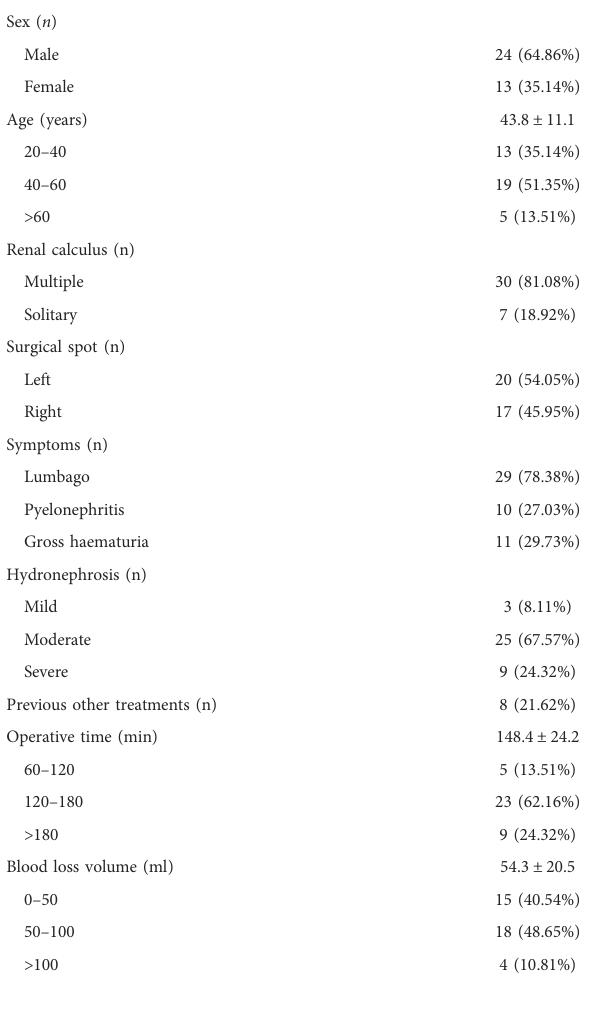
TABLE 1 Demographic characteristics and surgical